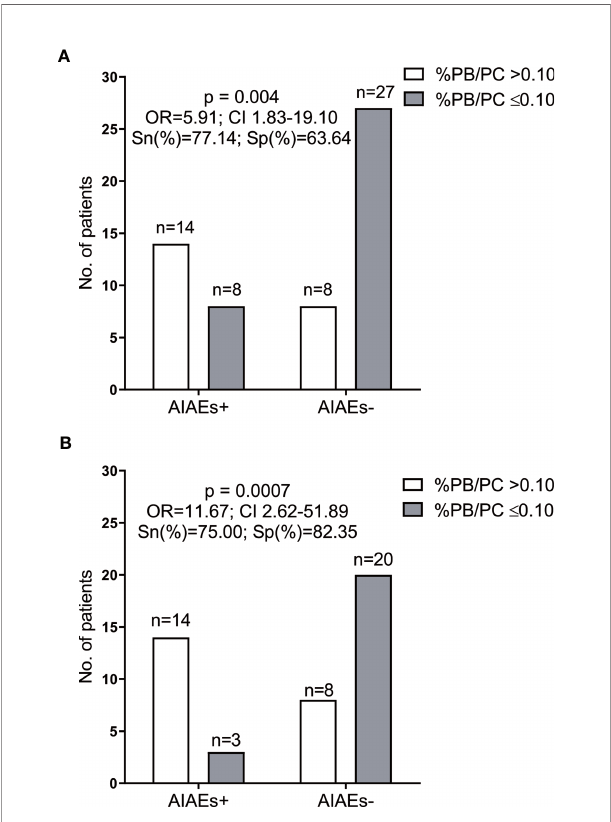
FIGURE 4 | Number of patients with (+) and without (-) autoimmune adverse events (AIAEs) classi fi ed according to plasmablasts/plasma cells percentages before alemtuzumab treatment initiation. (A) Analysis performed in all patients included in the study (n=57); (B) Analysis performed excluding patients who received natalizumab as the last treatment before alemtuzumab (n=45). AIAES, autoimmune adverse events; PB/PC, plasmablasts/plasma cells; N, number; OR, odds ratio; CI, con fi dence interval. ROC curves were used to establish cut-off values. p-value was obtained using Fisher ’ s exact